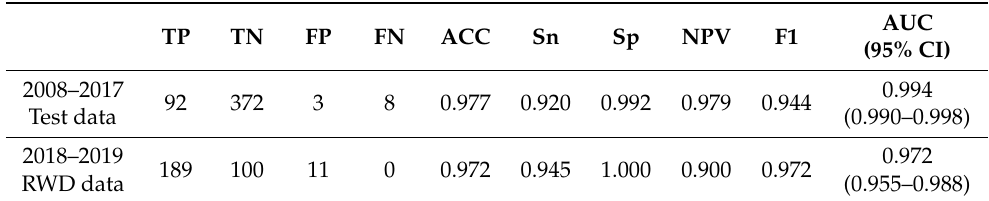
Table 1. The performance of SurgHipNet classification results in the testing dataset and real-world dataset.